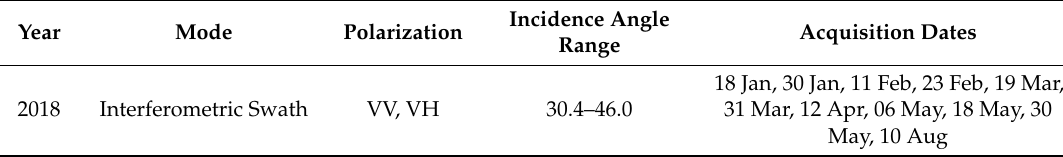
Table 2. Sentinel-1 SLC data used in Davos, Swiss Alps study